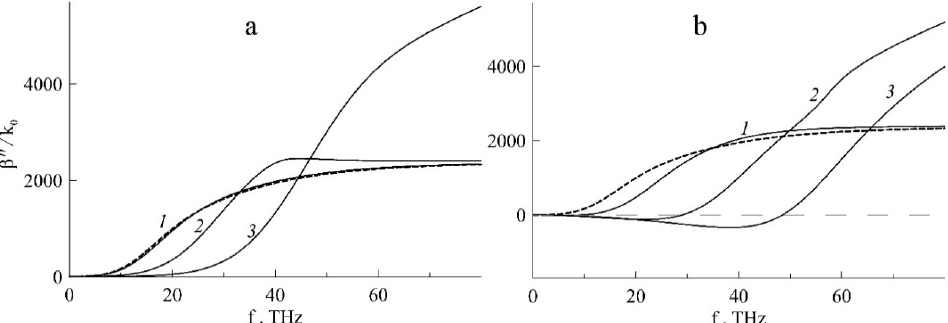
Figure 5. Frequency dependence of the imaginary part of the propagation constant in a structure with doped and inverted graphenes ( a , b ); ε 2 = 10, µ = 0; 0.02; 0.06; 0.10 eV (dashed curve and curves 1–3).